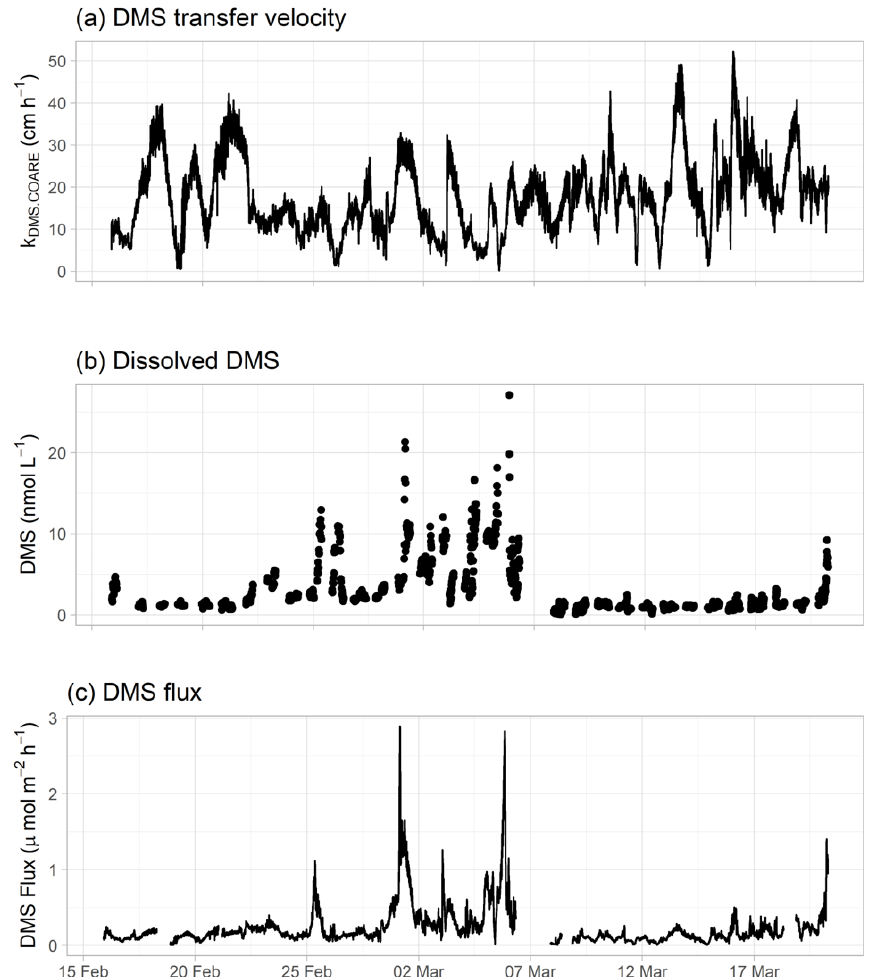
Figure 23. Time series of (a) DMS transfer velocity, (b) dissolved DMS concentration, and (c) estimated DMS flux to the atmosphere plotted against time in